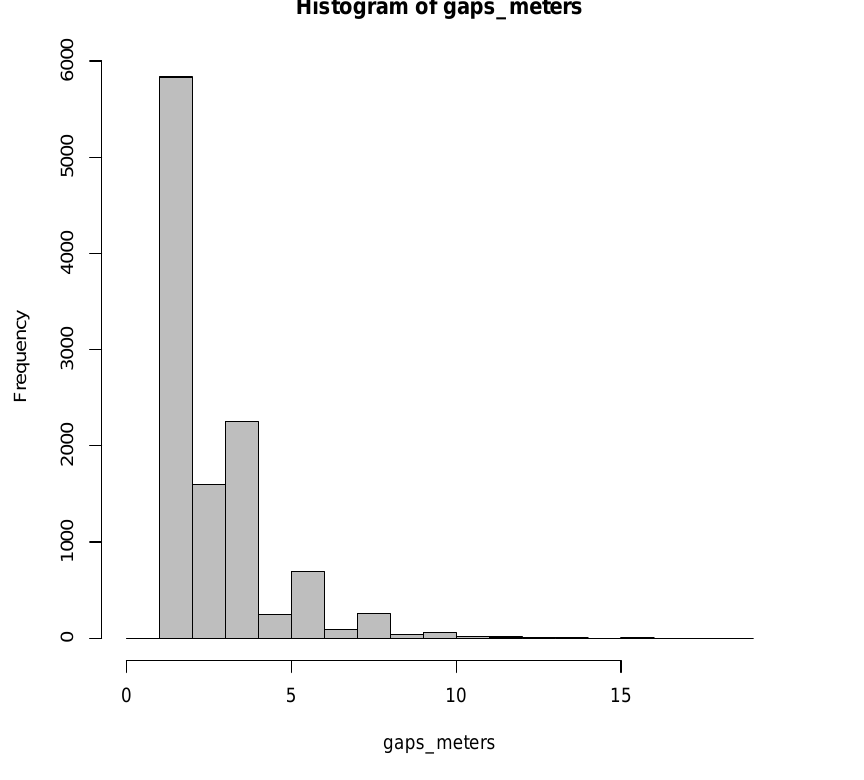
Figure 5. Histogram showing the distribution of gap sizes in the simulated “GAPPY” row population (maximum gap size = 18.3